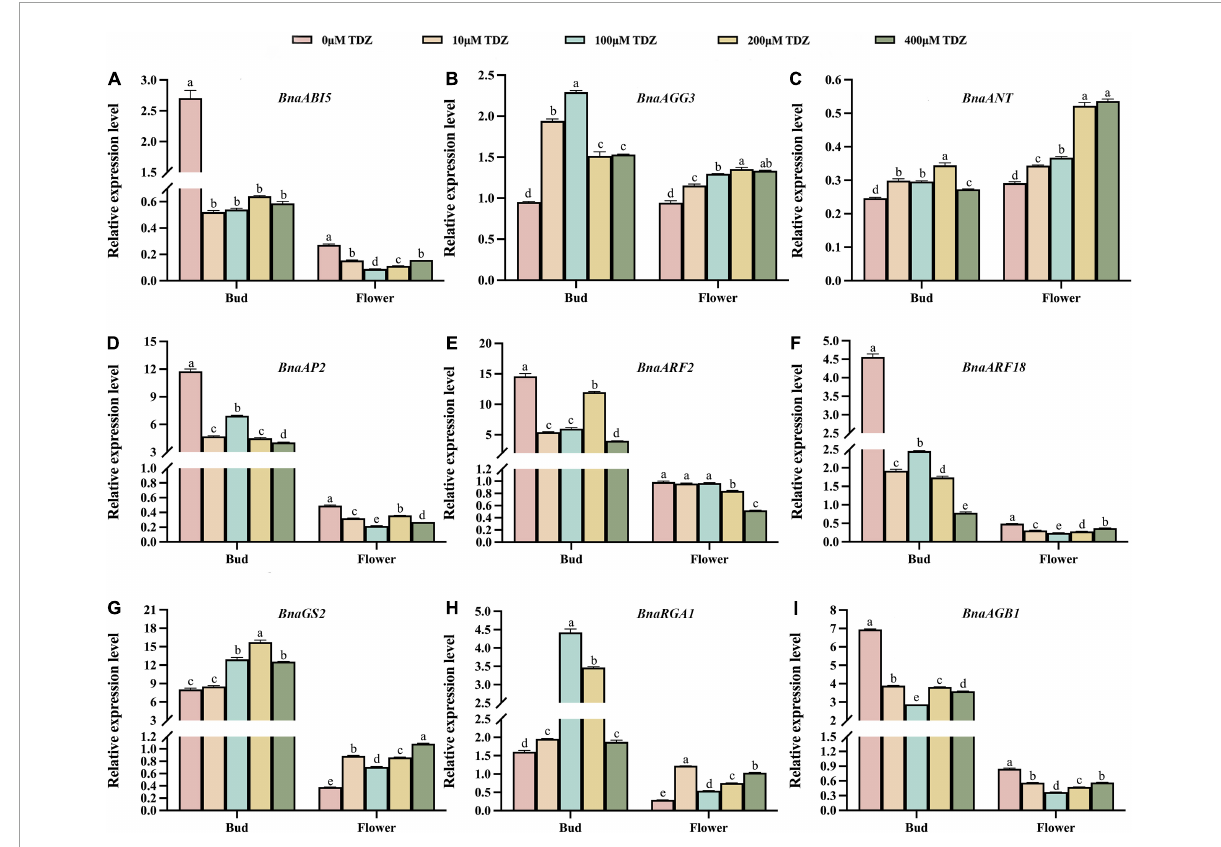
FIGURE8 Comprehensive analysis of relative transcriptional levels of seed size-related genes in buds and flowers of B. napus . (A–I) lists the relative transcriptional levels of nine genes associated with seed size in buds and flowers. Among them, the pink, orange, blue, yellow and green columns represent the relative transcriptional levels of genes in buds and flowers treated with 0 µ mol/L, 10 µ mol/L, 100 µ mol/L, 200 µ mol/L and 400 µ mol/L TDZ, respectively. Three biological replicates and three technical replicates were carried out using buds from 3 to 5 days before flowering and 10-day-old blooming flowers. Mean ± Standard error ( n = 3). Different letters suggest significant differences (Duncan’s multiple range test, p ≤